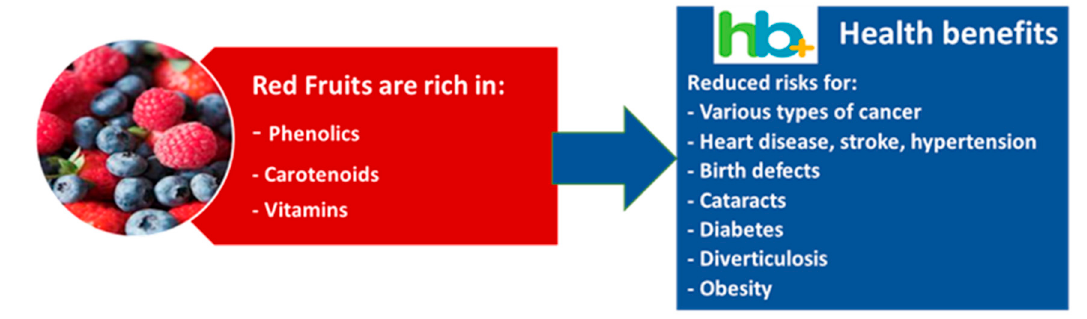
Figure 6. Health effects of red fruits. Table 11. Some examples of antioxidant activity values of red fruits by ORAC